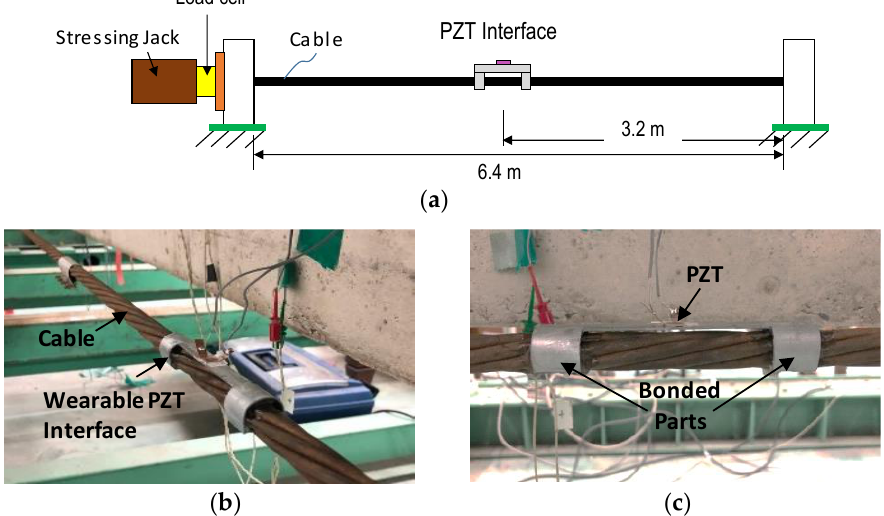
Figure 14. Experimental setup of lab-scale cable structure: ( a ) schematic of test setup; ( b ) cable equipped with wearable PZT interface; ( c ) attachment method. Table 7. Test cases of tension forces in the cable structure.